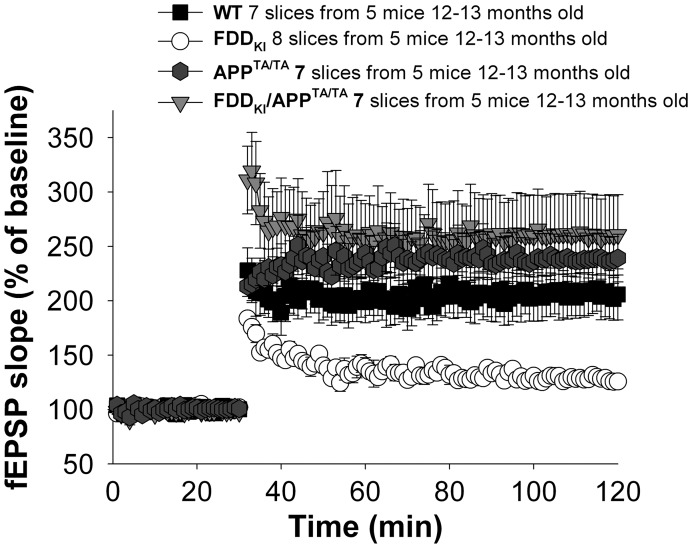
A Thr668Ala mutation on APP prevents the synaptic deficits of FDDKI mice.Normal LTP in FDDKI/APPTA/TA and APPTA/TA compared with WT mice by two-way ANOVA (FDDKI/APPTA/TA versus WT mice: F(1,12) = 1.936; P = 0.187; APPTA/TA versus WT F(1,12) = 0.989; P = 0.338). Two-way ANOVA shows impaired LTP in FDDKI mice when compared with WT (F(1,13) = 15.125; P = 0.002), to FDDKI/APPTA/TA (F(1,13) = 12.759; P = 0.004) or to APPTA/TA mice littermates (F(1,13) = 22.396; P<0.0001).